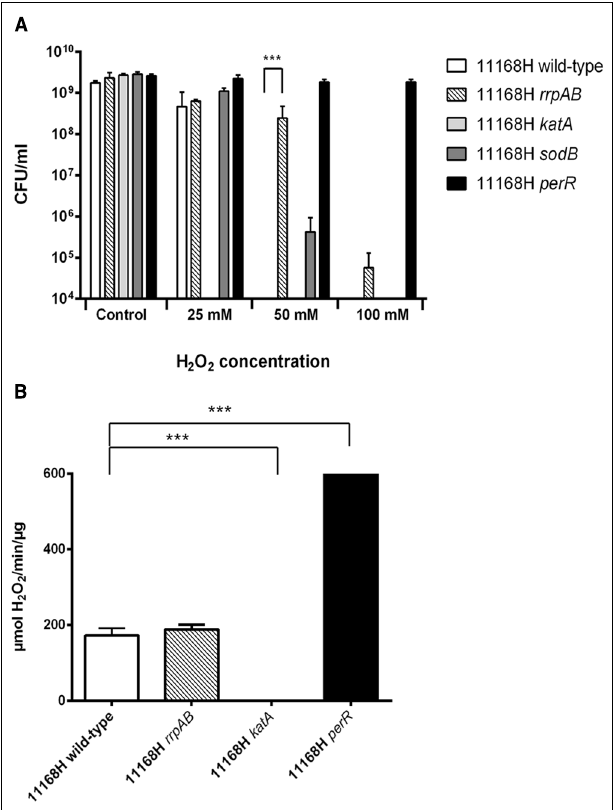
FIGURE 3 | (A) Effect of oxidative stress on the survival of C. jejuni 11168H wild-type strain and rrpAB , katA , and perR mutants. C. jejuni strains were incubated with 25, 50, or 100 mM H 2 O 2 for 15 min at 37°C and bacterial survival assessed. (B) Catalase activity assays were performed on bacterial whole cell lysates from the 11168H wild-type strain and rrpAB , katA and perR mutants for 1 min. Asterisks denote a statistically significant difference (*** p < 0.001).